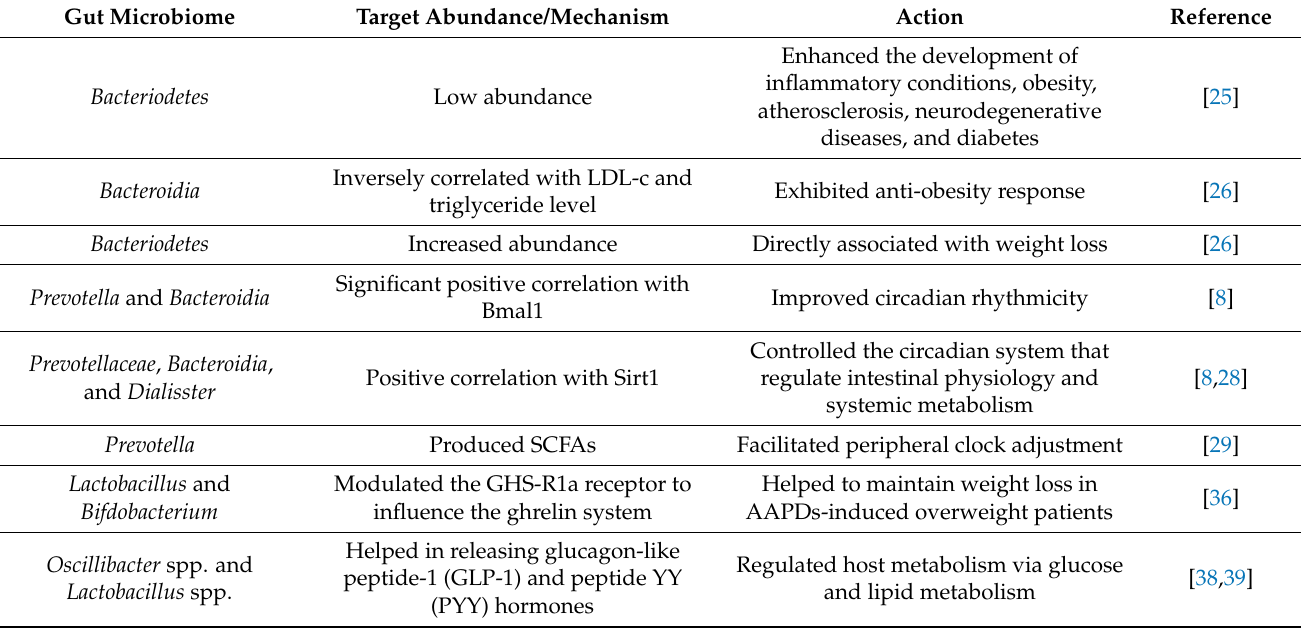
Table 2. Gut microbiota and their targeted mechanisms and